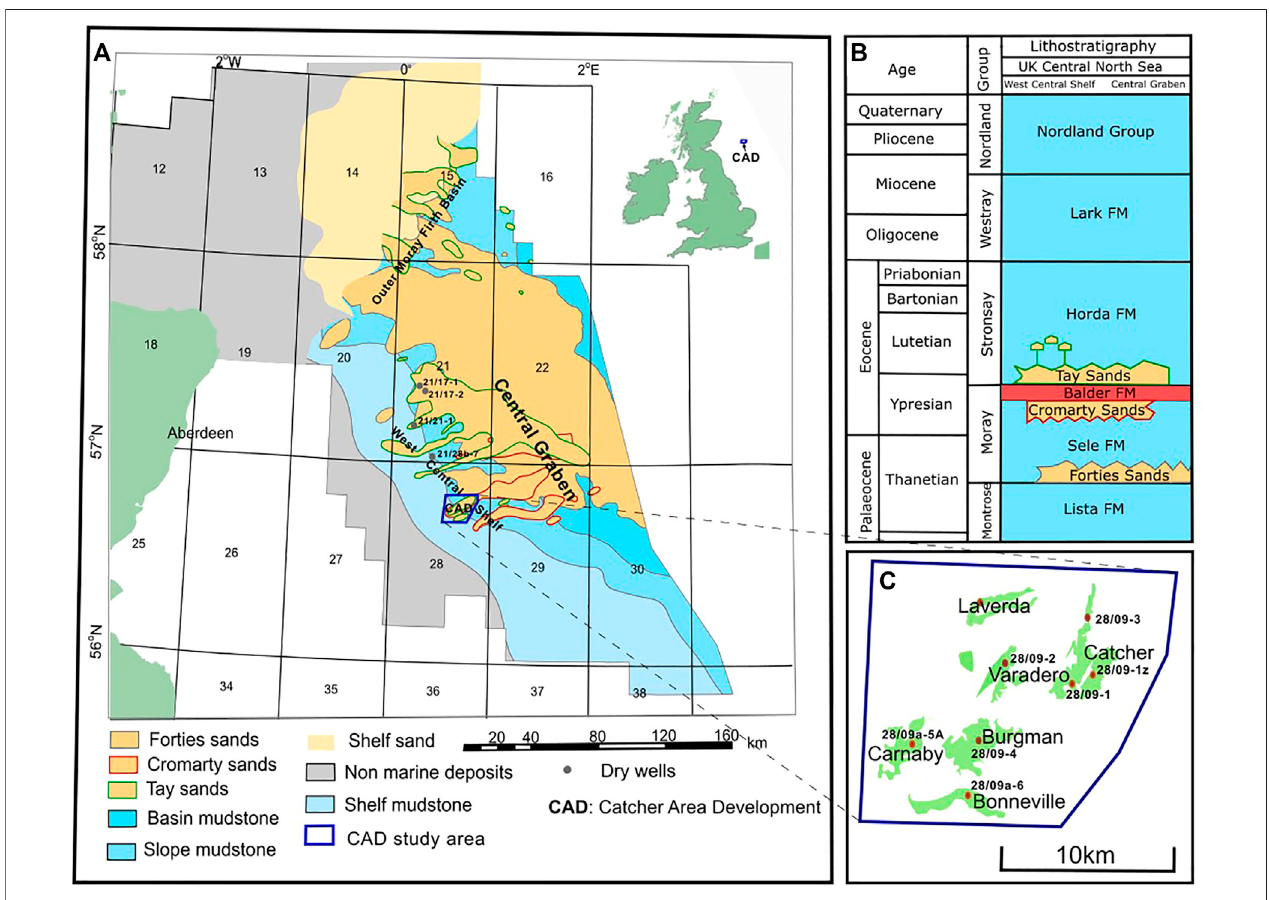
FIGURE 1 | (A) Regional map and (B) stratigraphic column highlighting the distribution of Tay (depositional and injected), Cromarty and Forties sandstone members in the Central North Sea. The Catcher Area Development lies in the West Central Shelf of the UK Central North Sea and is highlighted in blue. (C) The distribution of hydrocarbon fi elds in the study area is highlighted. All fi elds in the CAD except Laverda have cored wells.